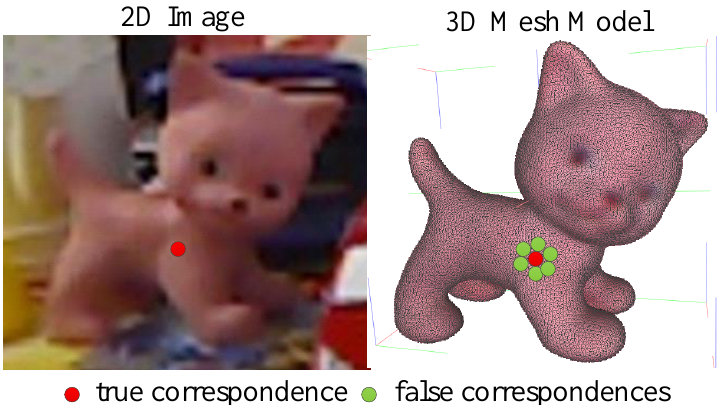
Figure 2. The illustration for the dense matching correspondences using softmax